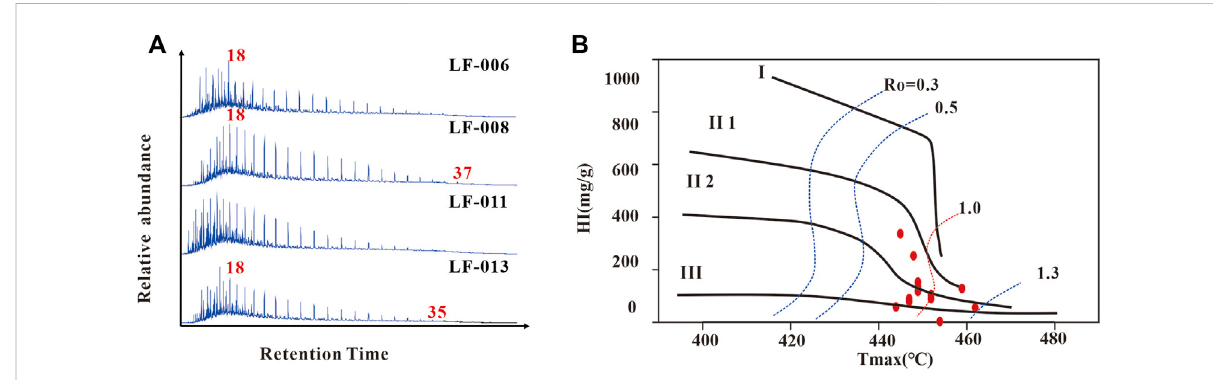
FIGURE 5 Analysis of the source of the organic matter in Dalong Formation. (A) Normal alkane distribution of the source rocks, and (B) crossplot of Tmax with HI of the source